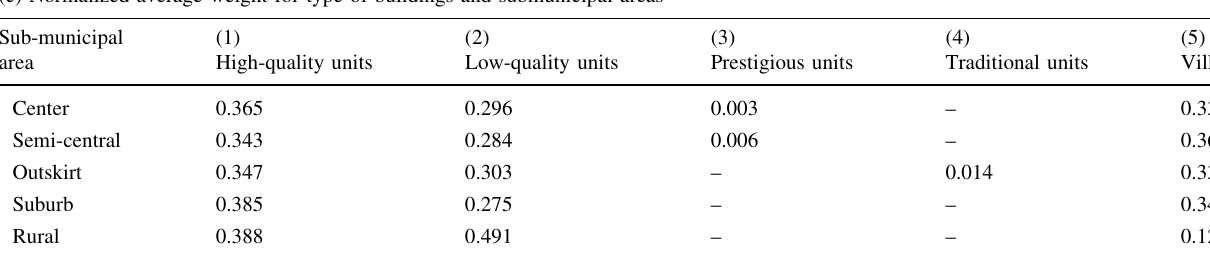
(c) Normalized average weight for type of buildings and submunicipal